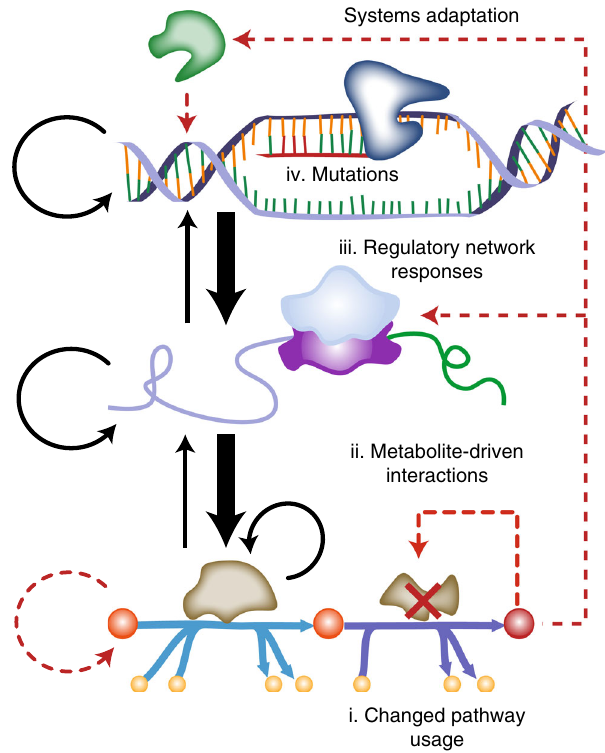
Fig. 7 A model of biological systems adaptation following the KO of key metabolic enzymes. (i) Suboptimal pathway usage limited allocation of carbon to biomass precursors. (ii) Perturbed metabolite levels triggered transcription regulatory network (TRN) responses in the uKOs. (iii) Activation of the TRN revealed a hierarchy of regulation involving competing and overlapping regulatory interactions between various system components including DNA, RNA, and proteins. (iv) Mutations selected during adaptive evolution changed many regulatory networks, and